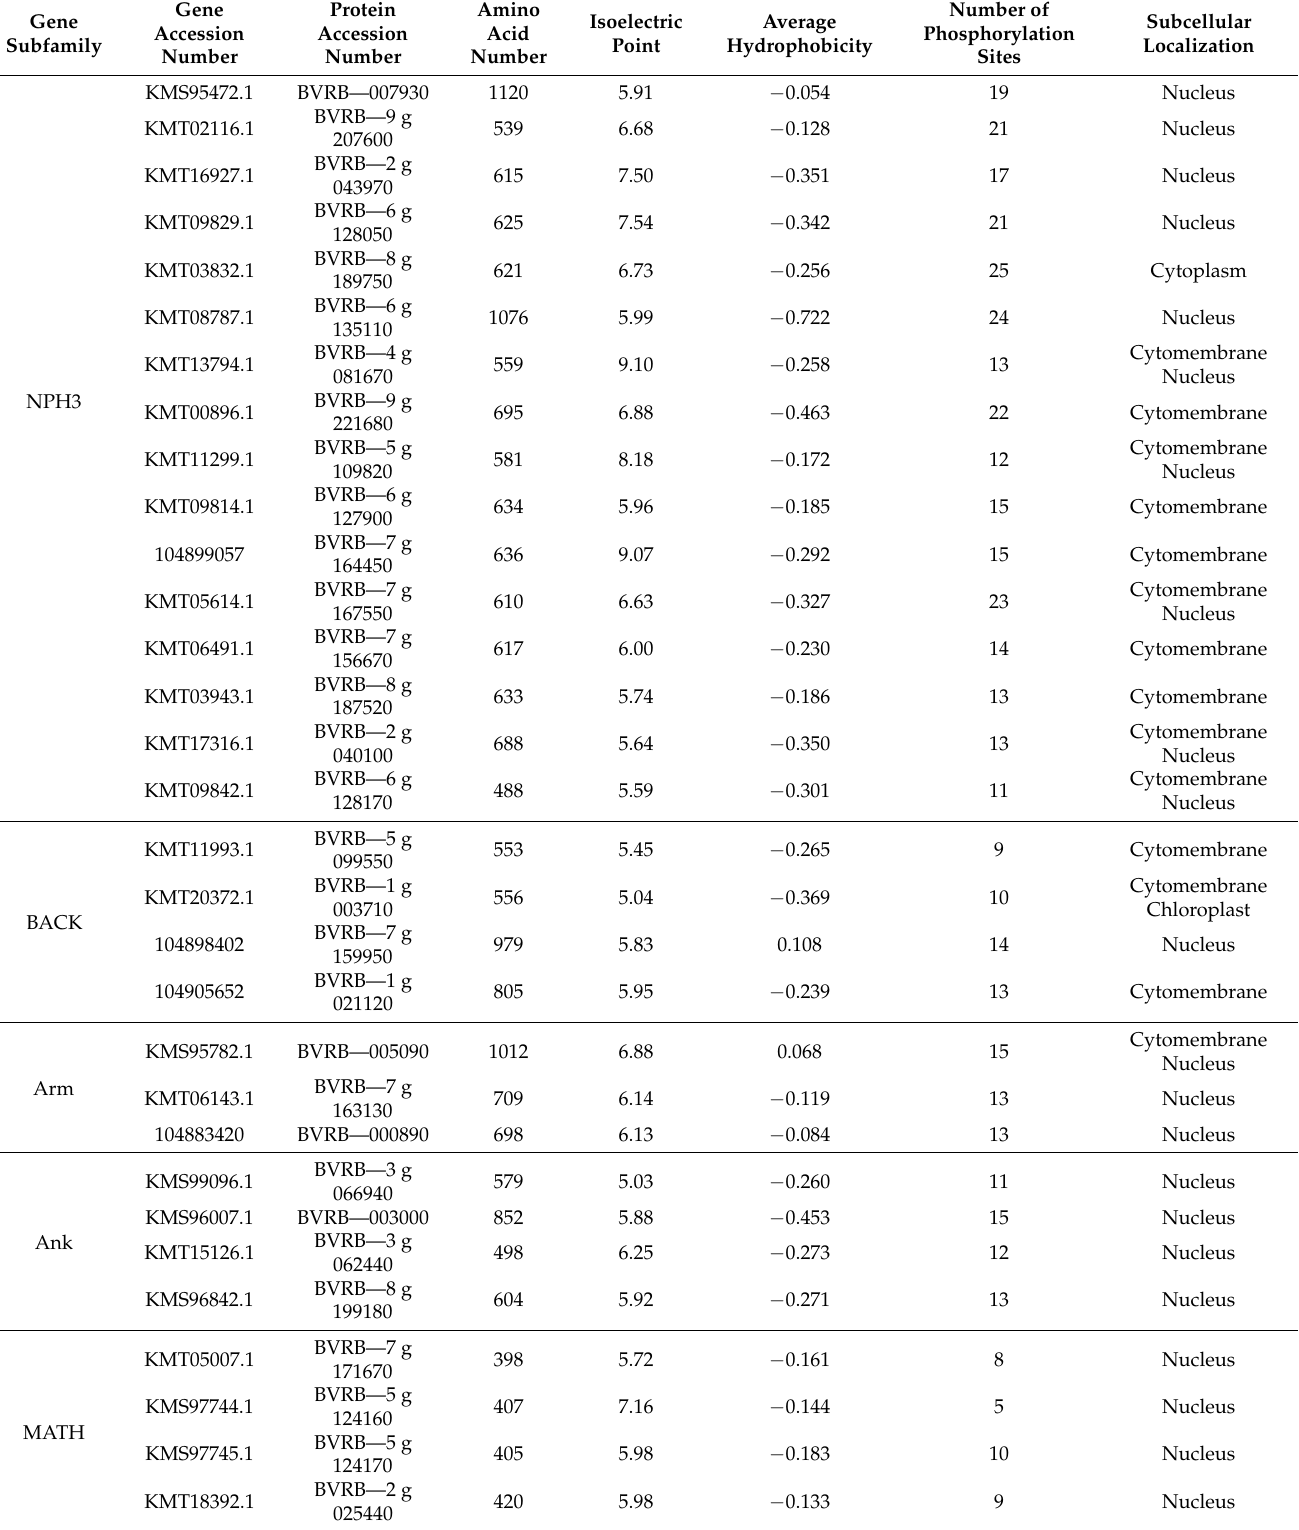
Table 2. Physical and chemical properties of the BTB protein family in sugar